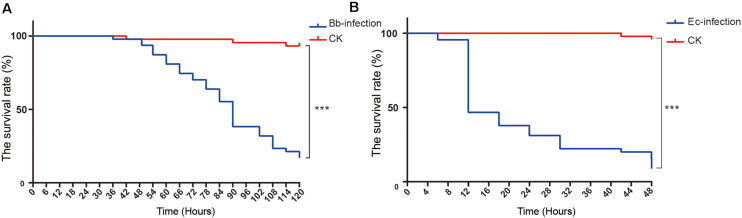
The survival curves and transcriptomic changes of A. suturalis nymphs injected with B. bassiana, E. cloacae or mock (Tween-80). (A) The survival curve of B. bassiana-infected nymphs; (B) The survival curve of E. cloacae-infected nymphs. The log-rank test was used to evaluate the significance of differences between groups (***p < 0.001).